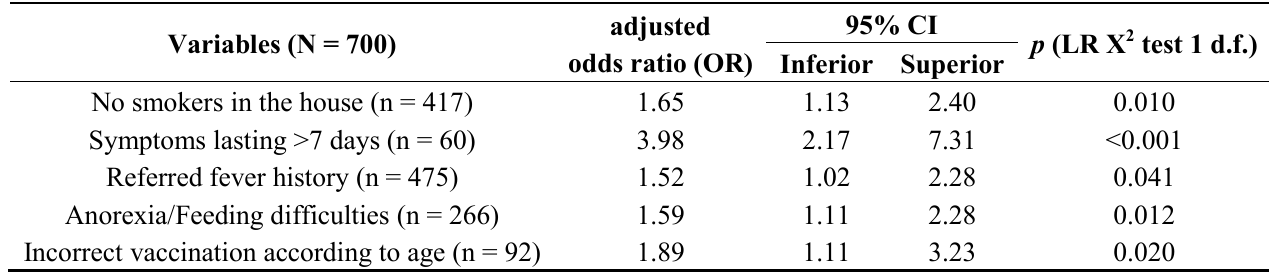
Table 2. Risk factors independently associated with prior to hospitalization antibiotic